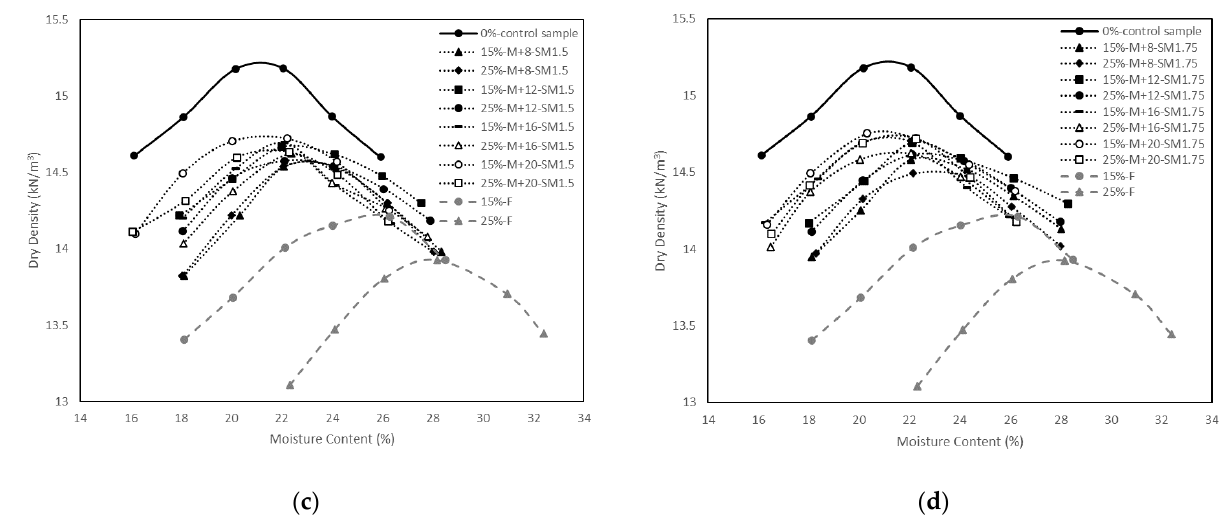
Figure 4. Compaction curves for the control sample, fly ash-stabilised soil samples, and alkali-activated fly ash-stabilised soil samples with different alkali dosages (M+) and silica moduli (SM): ( a ) SM = 1; ( b ) SM = 1.25; ( c ) SM = 1.5; ( d ) SM = 1.75.